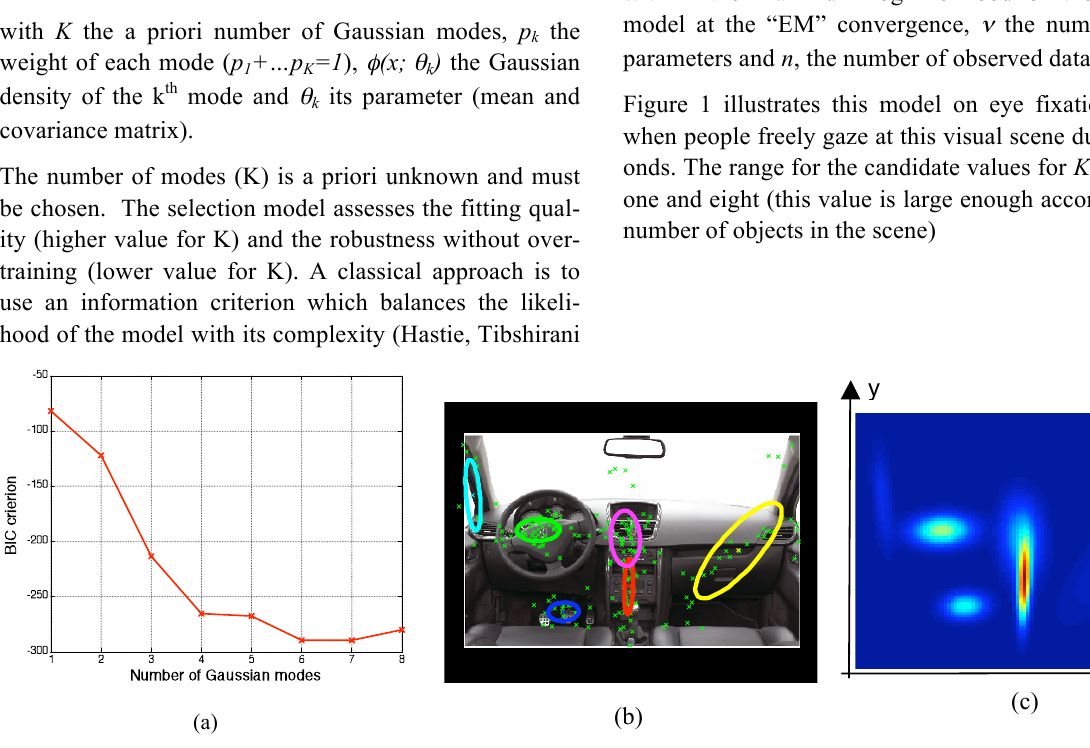
Figure 1: (a) Evolution of the BIC for all the K candidate values, (b) Eye fixations during a free viewing of this scene and localization of the Gaussian modes after the model selection, (c) Spatial density f(x, y)of the eye fixations after the model selection. Six Gaussian modes are defined to best fit the experimental data